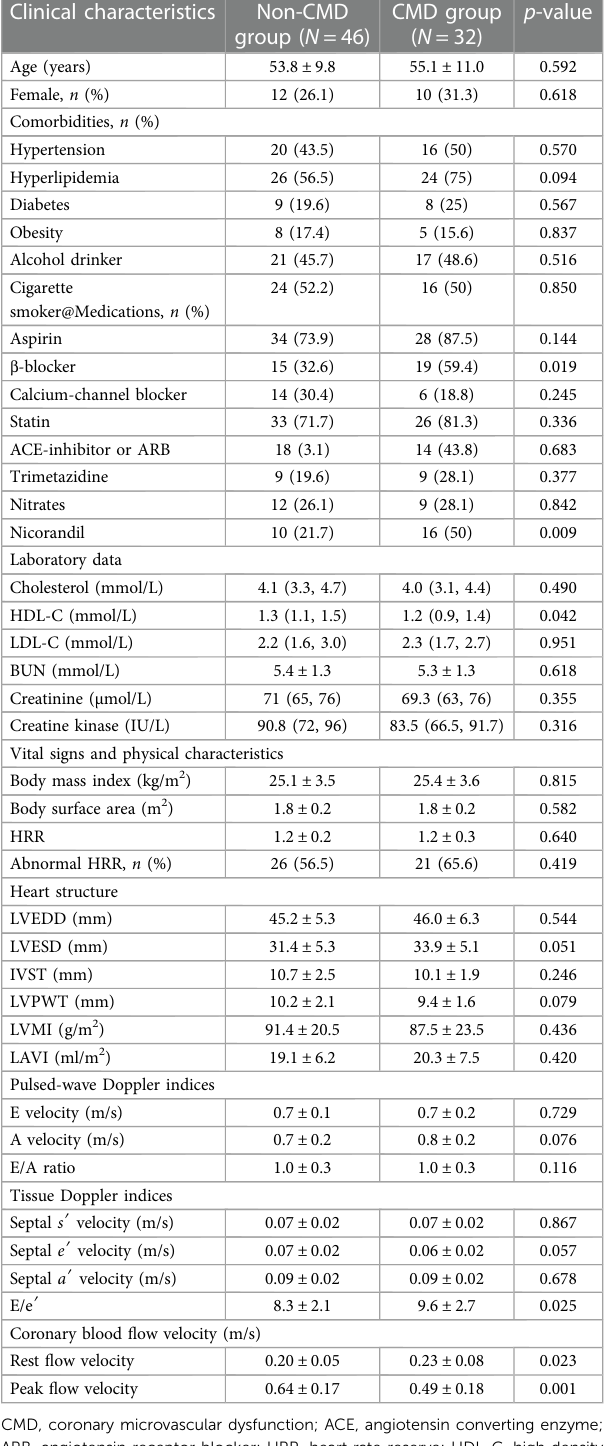
TABLE 1 Clinical characteristics of the patients with or without CMD. Clinical characteristics